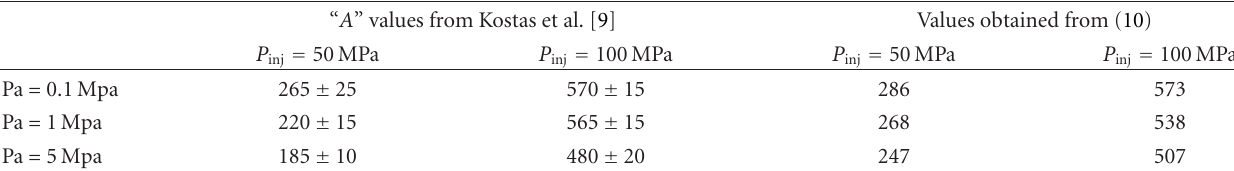
Table 4: Experimental determined values of “ A ” from [9] and values of